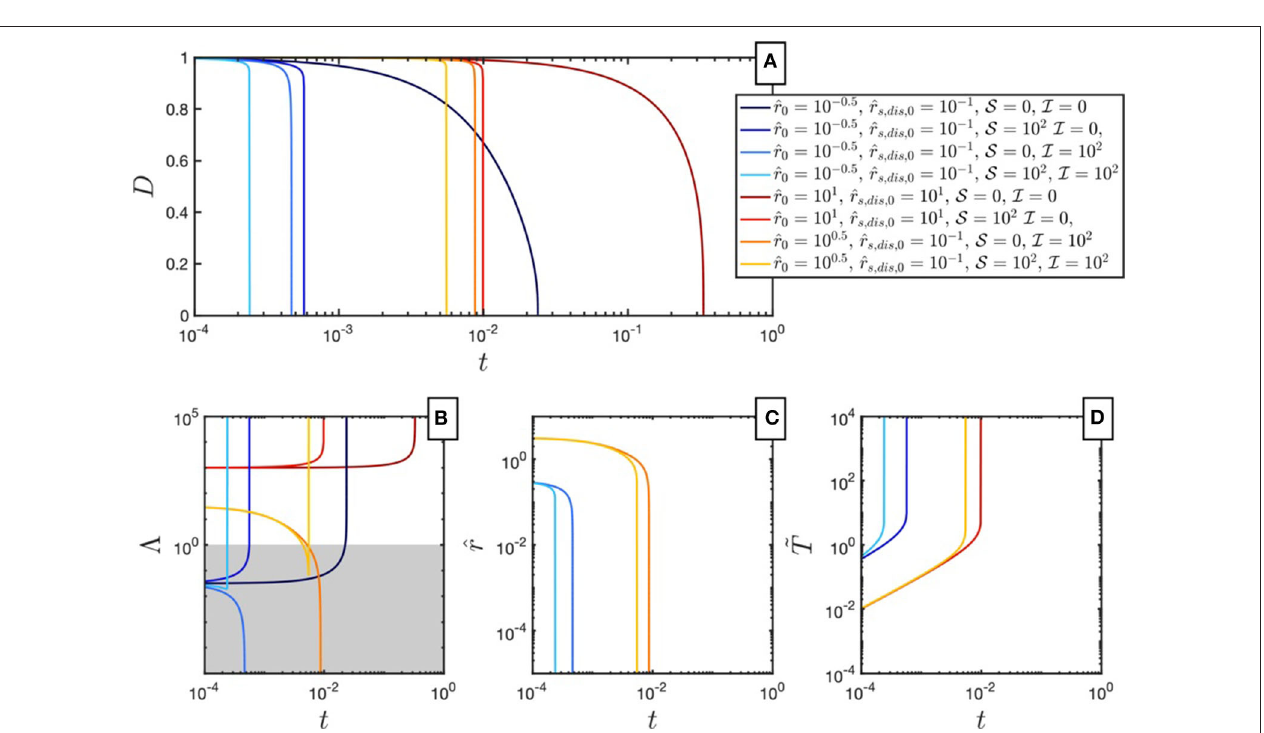
r s , dis ,0 , and T ′ 0 and r 0 for Earth-like parameters. ˆ ˆ